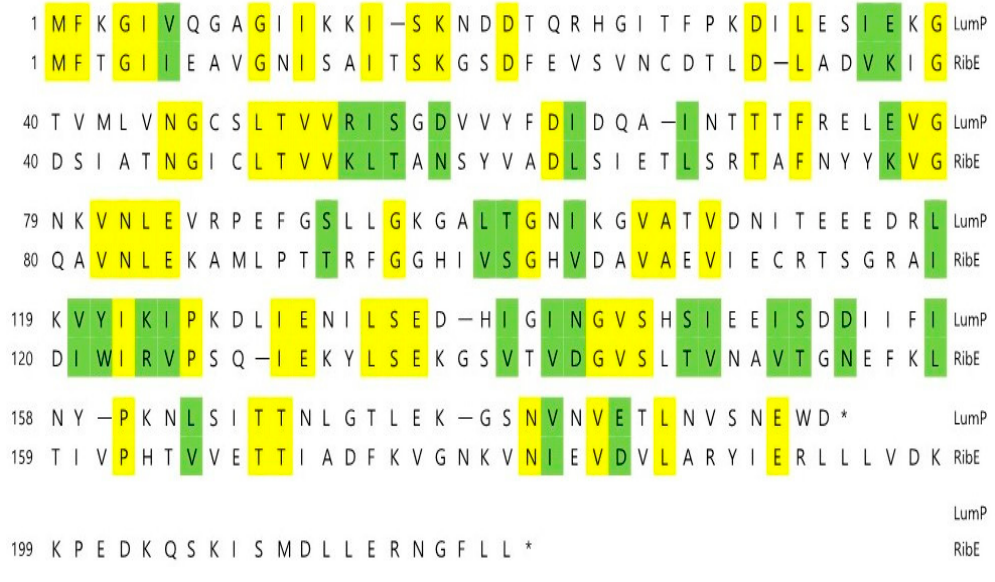
Figure 3. Comparison of amino acid sequences of lumazine protein (LumP) and riboflavin synthase (RibE) from Photobacterium phosphoreum. Identical or similar amino acids are shown boxed by yellow and green, respectively. Bars and asterisks indicate amino acid gaps and stop codons, respectively.